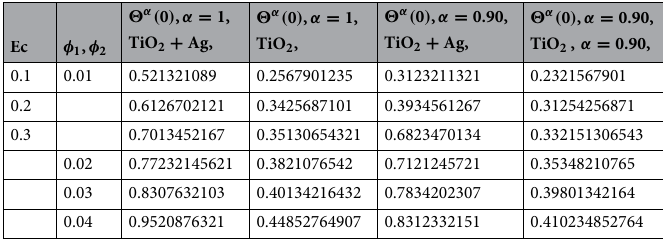
Table 3. Heat Transfer rate using both cases. When Pr = 21.